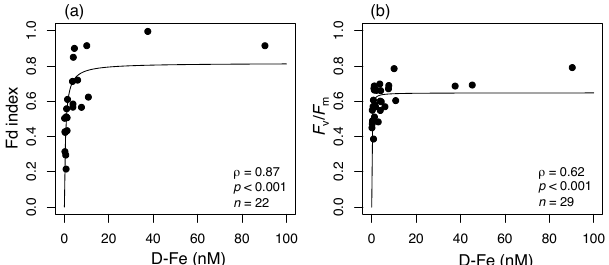
and Chl a to the sum of these pigments in the pellets collected for the Fd and Fld assays at each sampling station.